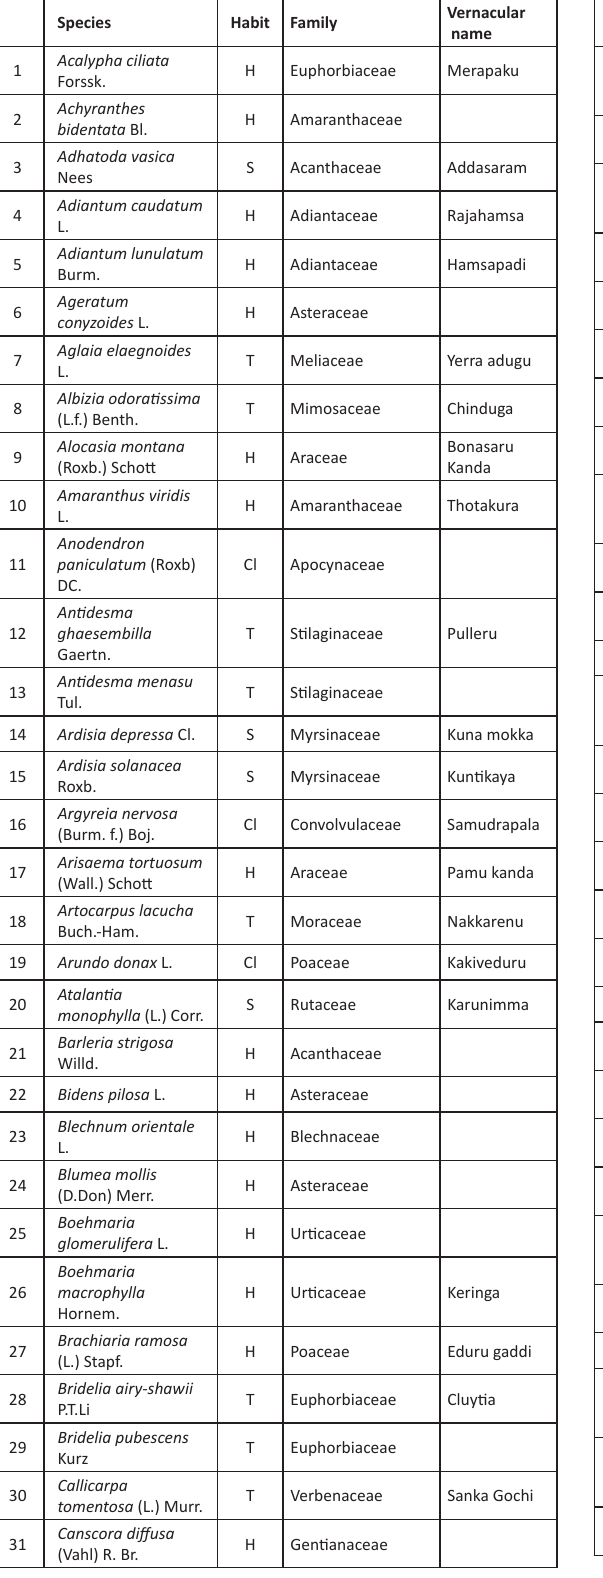
Table 1. List of plant species recorded in the sacred grove of